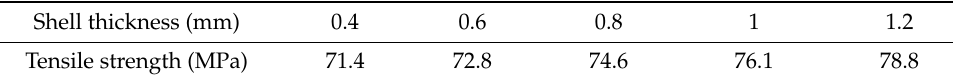
Table 6. Tensile strength vs. shell thickness.